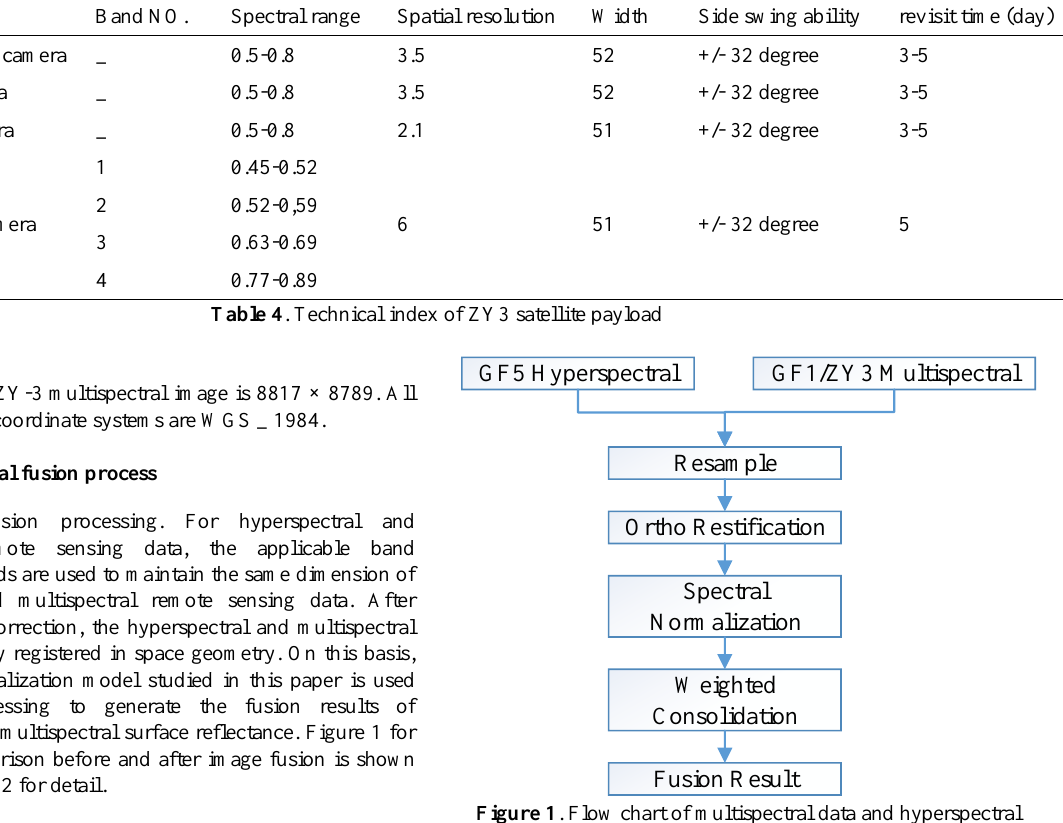
Figure 1 . Flow chart of multispectral data and hyperspectral data fusion